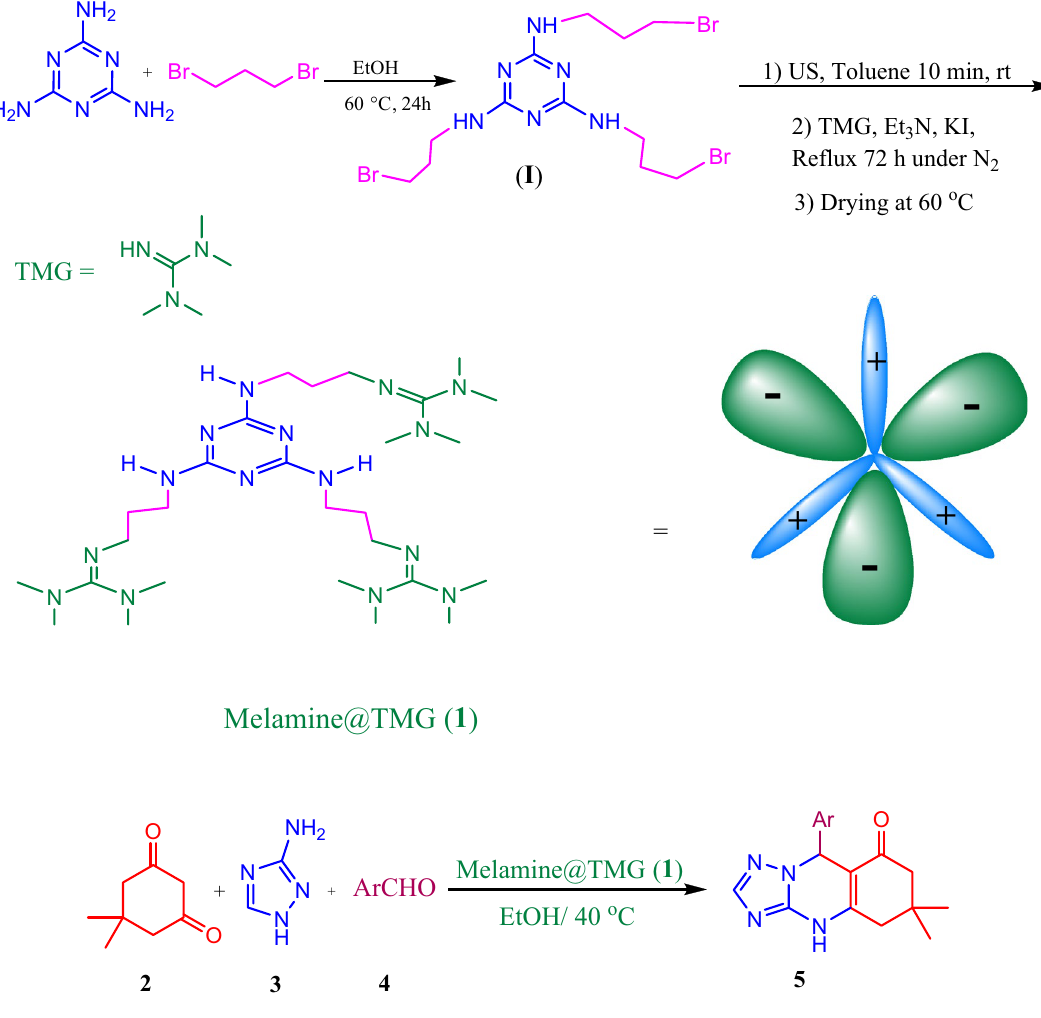
Scheme 1. Preparation of nano-ordered multifunctional Melamine@TMG organocatalyst and its application for the three-component synthesis of 1,2,4-triazoloquinazolinones 5a–j